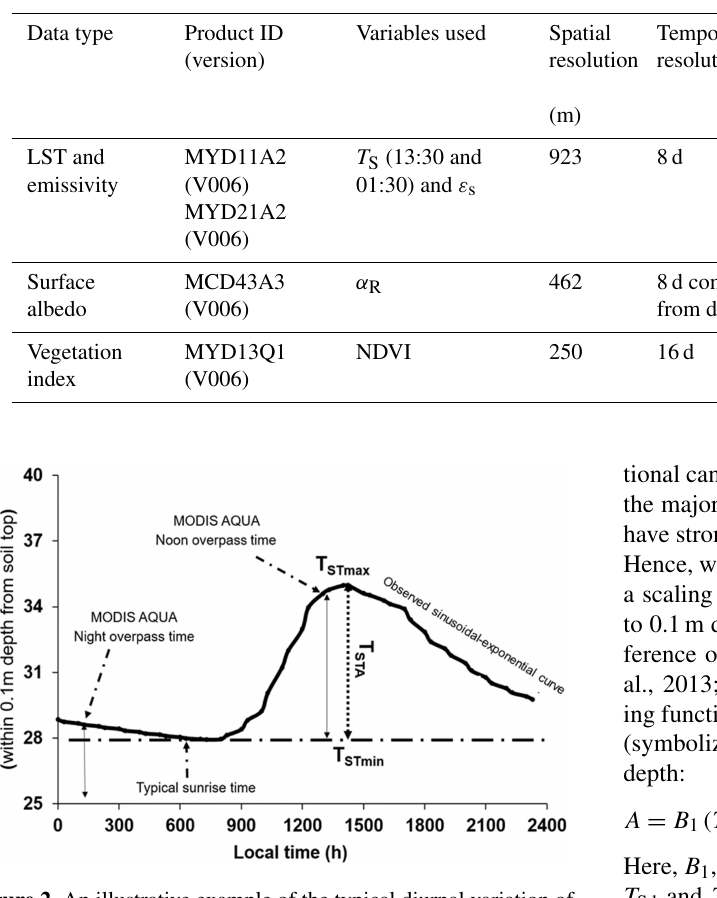
Table 2. A summary of MODIS Aqua optical and thermal remote sensing products used in the present study.